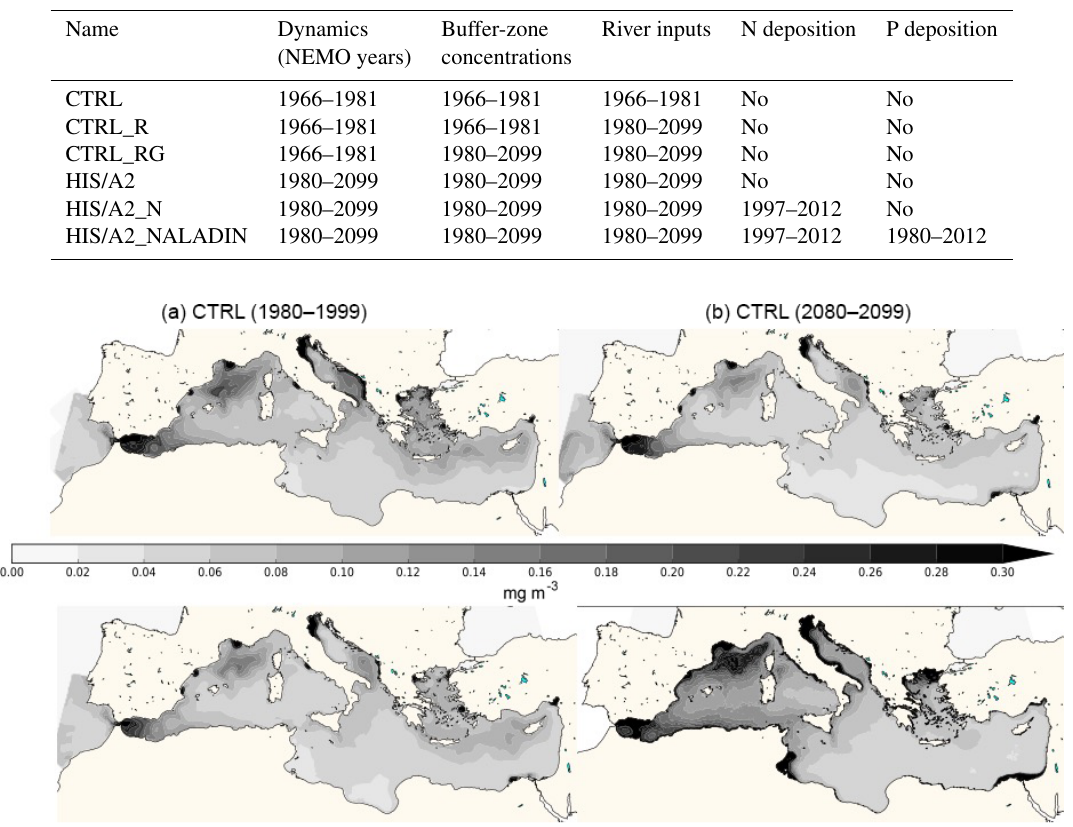
Table 1. Description of the simulations. The years indicate the forcing years throughout the 120 years of simulation. The cycles are repeated in the CTRL simulations.